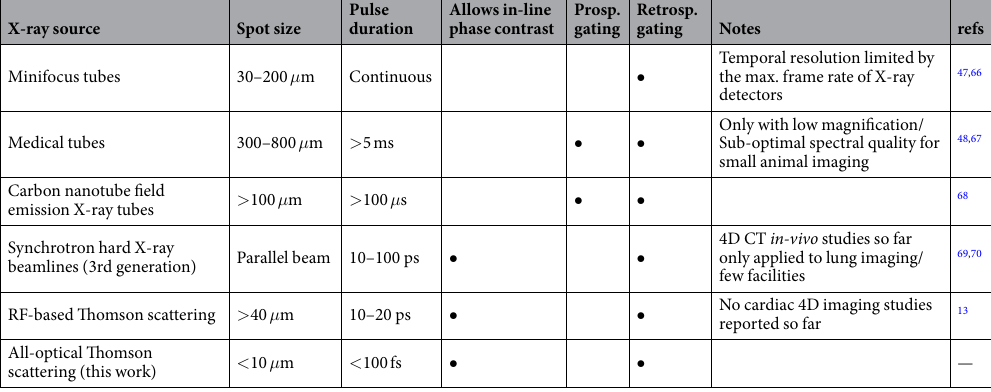
Table 1. Main parameters of X-ray sources suitable for application in 4D μ CT of the mouse